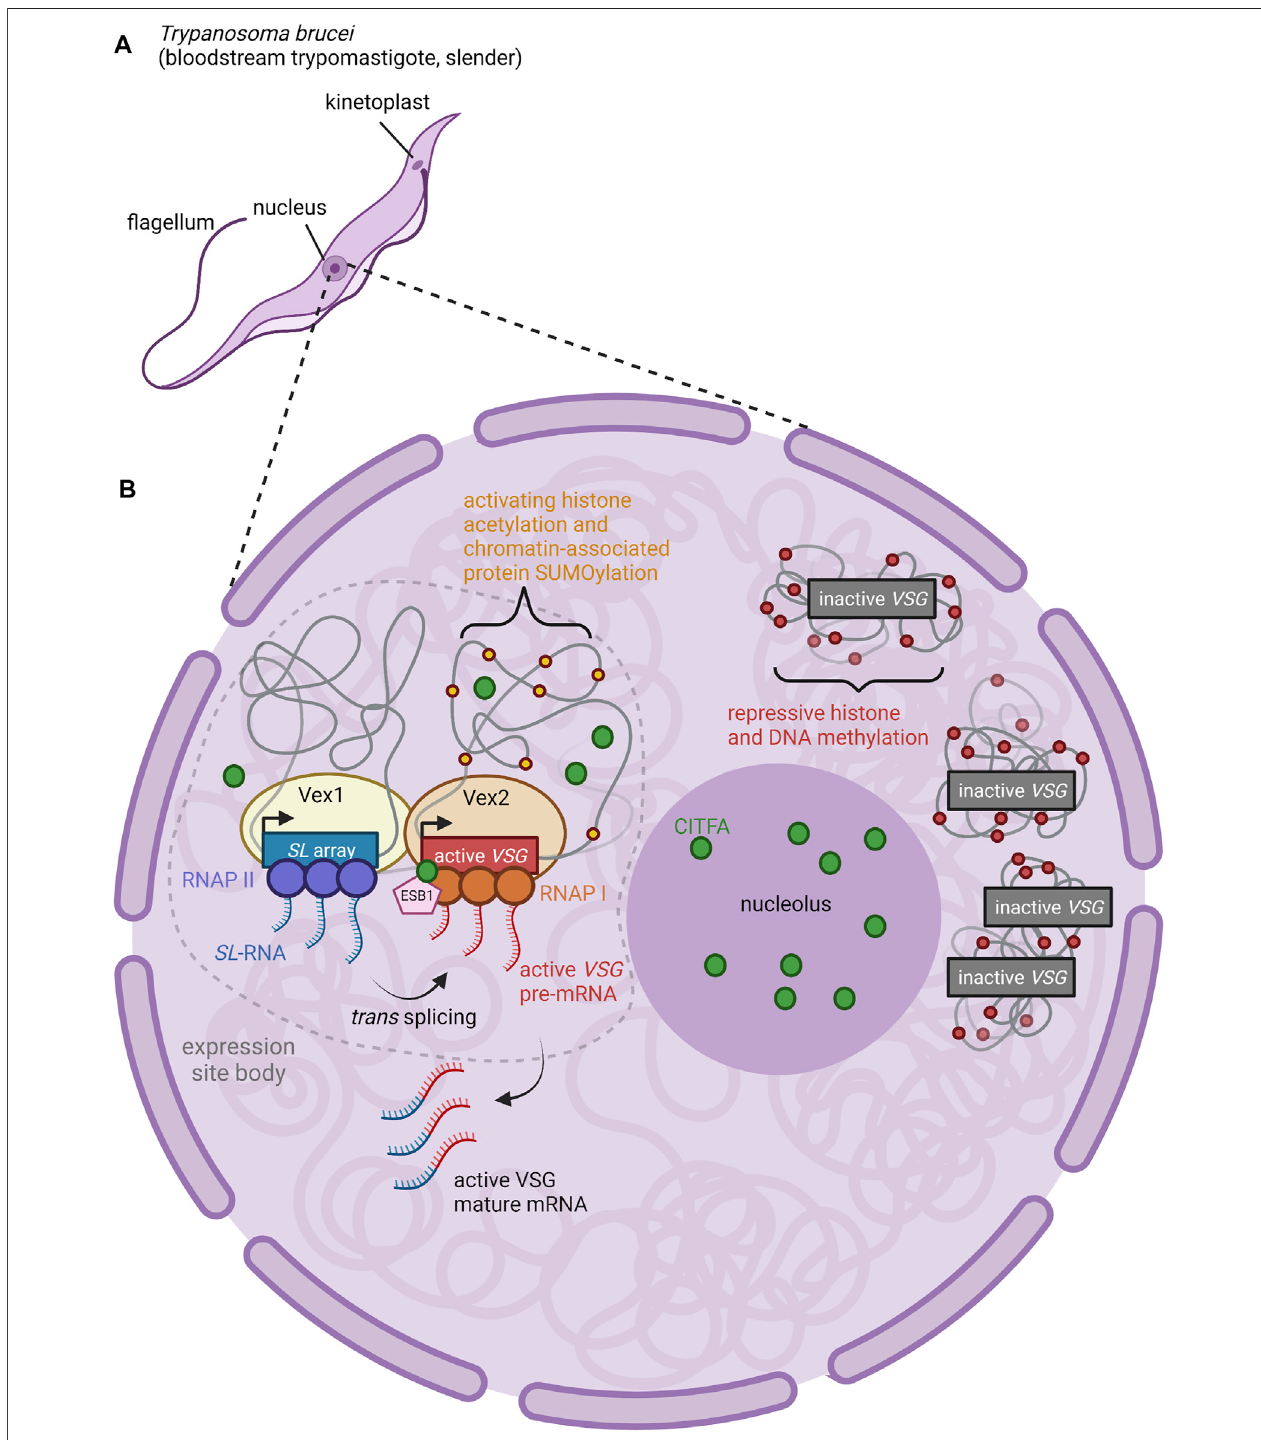
FIGURE2 | NuclearOrganization and Control ofVSG Expression. (A) Anatomy of a T. brucei cell. The long slender shape ischaracteristic ofthe bloodstreamform of the parasite, an actively proliferating stage which causes chronic parasitemia in infected hosts (Matthews, 2005). (B) The active BES VSG is expressed within an extranucleolar expression site body (ESB) (Navarro and Gull,2001).ESBs are enriched for RNAPolI, CITFA transcription factor complexes(green circles),and theESB- speci fi ctranscriptionfactorESB1(pinkpentagon)(Brandenburgetal.,2007;Nguyenetal.,2012;Nguyenetal.,2014;Escobaretal.,2021).BothCITFAandESB1 are required for transcription of the active VSG gene; the absence of these factors from inactive VSGs (relegated to heterochromatic regions outside of the ESB) contributes to the repression of inactive VSGs (Brandenburg et al., 2007; Nguyen et al., 2012; Nguyen et al., 2014; Escobar et al., 2021). Within the ESB, the proteins